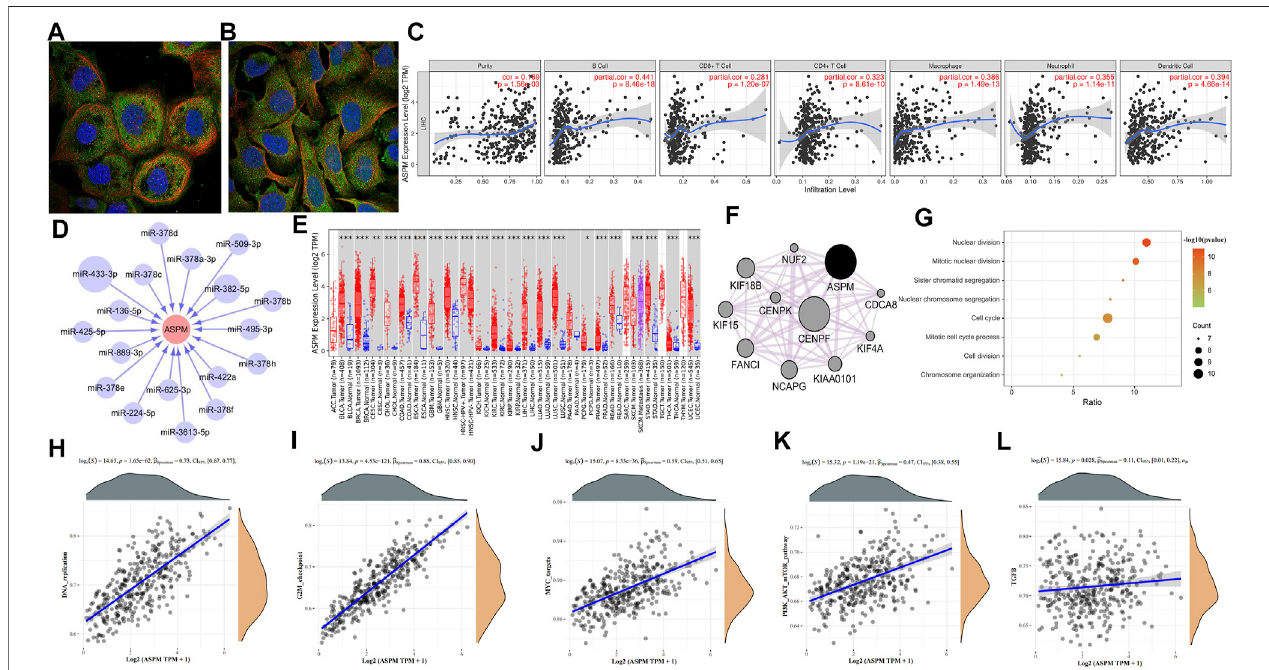
FIGURE2|(A) Fluorescencestainingof ASPM inA-431cellswasobtainedfromHumanProteinAtlasdatabase. (B) Fluorescencestainingof ASPM inU-2OScells was obtained from Human Protein Atlas database. (C) Correlation analysis of ASPM expression and immune in fi ltration evaluated by the purity-corrected partial Spearman ’ s rho test. (D) miRNA-gene interaction network constructed based on PITA, miRanda, TargetScan, and PicTar database. (E) ASPM expression in human normal and tumor tissues were statistically evaluated by the Wilcoxon test (F) The PPI network of ASPM and its co-expression genes was created by GeneMANIA softwareinCytoscape. (G) Biologicalprocessanalysisof ASPM co-expressedgenes (H – L) Thecorrelationbetween ASPM andpathwaywasexploredusingRsoftware GSVA package and was analyzed by Spearman correlation; the X-axis represents gene expression, the Y-axis represents the pathway score, and the density curve on the right represents the distribution trend of the pathway score; the density curve on the upper side represents the distribution trend of gene expression; the uppermost value represents the correlation p -value, correlation coef fi cient, and correlation calculation method. *: p -value < 0.05; **: p -value < 0.01; ***: p -value <